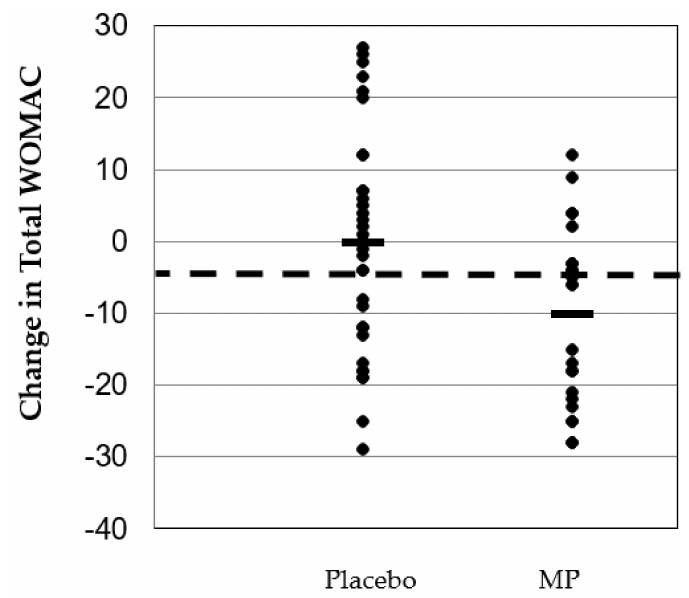
Figure 2. Changes in total WOMAC score after eight weeks of supplementation. The placebo group ( n = 34) reported an average decrease in total WOMAC score of − 0.26 points. Of the 34 scores in the PLA group, 12 (35.2%) scores experienced a reduction in their total WOMAC score more than the entire study average. The proprietary milk protein concentrate group ( n = 24) reported an average decrease in total WOMAC score of 10.21 points. Of the 24 scores in the proprietary milk protein concentrate group, 15 (62.5%) scores decreased their total WOMAC score more than the entire study average. Dotted line = average change in total WOMAC for entire study cohort. Black horizontal bars = average change in total WOMAC for each study group.